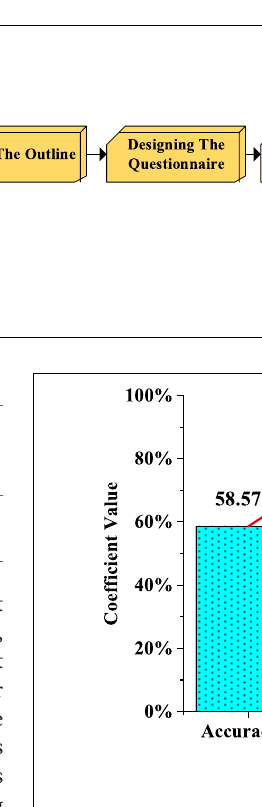
FIGURE 7 | Logistic model performance